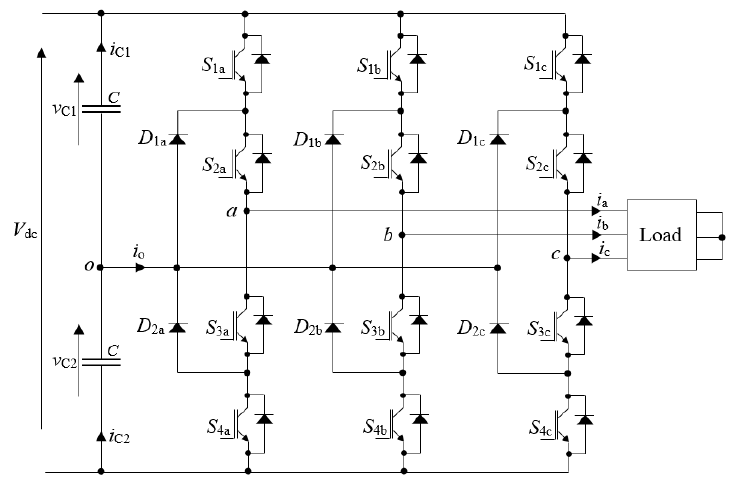
Figure 1. Scheme of the 3L-NPC converter. Table 1. Switching states and output voltages v xo with x ∈ { a , b , c }